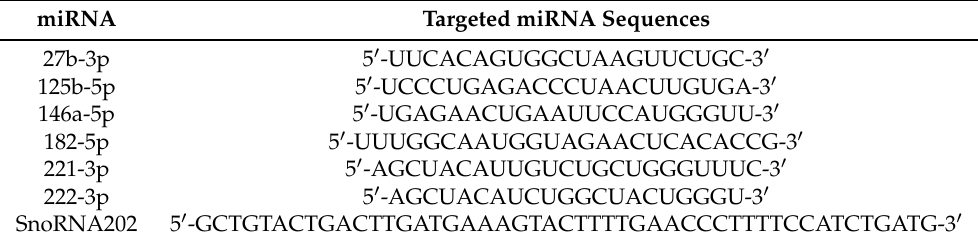
Table 1. Targeted miRNA sequences.